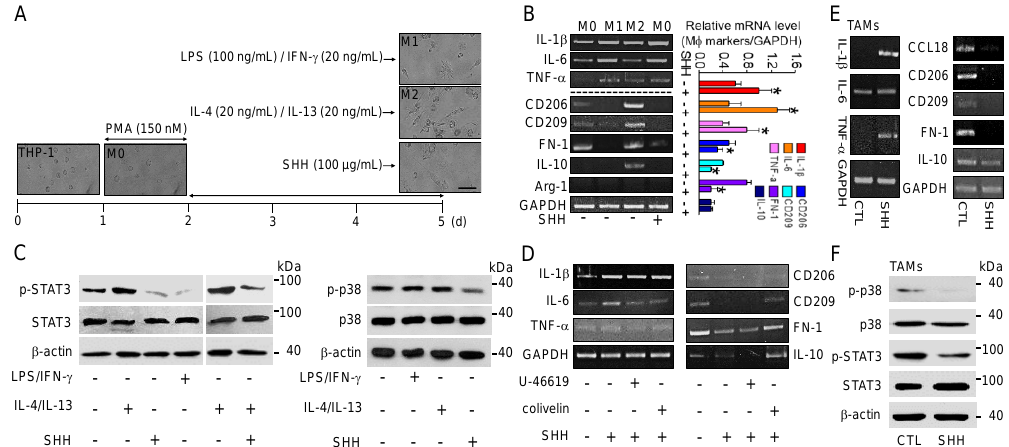
Figure 3. SHH-induced upregulation of M1 markers and downregulation of M2 markers in both human macrophages and tumor-associated macrophages (TAMs). ( A ) PMA-treated THP-1 polarization into M1 and M2 macrophages by LPS/IFN-γ and IL-4/IL-13 treatment for 3 days, respectively. M0 macrophages were activated by SHH. Ten independent experiments were performed ( n = 10). Scale bar, 50 μm. ( B ) SHH-induced upregulation of IL-1β, IL-6, and TNF-α and downregulation of CD206, CD209, and fibronectin-1 (FN-1) in the macrophages. SHH was added to M0 cells for 3 days. The bar graph shows the relative mRNA levels of the macrophage markers compared to that of GAPDH. Each bar is the mean ± SD obtained from four independent experiments ( n = 4). * p < 0.05 compared to each corresponding control. ( C ) SHH-induced downregulation of STAT3 and p38 activities in THP-1-differentiated M0 cells. LPS/IFN-γ, IL-4/IL-13, and/or SHH was added to M0 cells for 8 h. Total protein (35 μg of protein per lane) was analyzed by immunoblotting assay. ( D ) Reduction of SHH’s effect on the mRNA expression of the M1 and M2 markers by STAT3 activator. U-46619, colivelin, and SHH were added to M0 cells for 48 h. ( E ) SHH-induced upregulation of IL-1β, IL-6, and TNF-α and downregulation of CD206, CD209, fibronectin-1 (FN-1), and IL-10 in TAMs. SHH was added to TAMs for 48 h. ( F ) SHH-induced downregulation of STAT3 and p38 activities in TAMs. SHH was added to TAMs for 8 h. Total protein (35 μg of protein per lane) was analyzed by immunoblotting assay. GAPDH and β-actin were used as loading controls for comparing the mRNA and protein expression levels among treatments, respectively. Five independent experiments were performed ( n = 5).